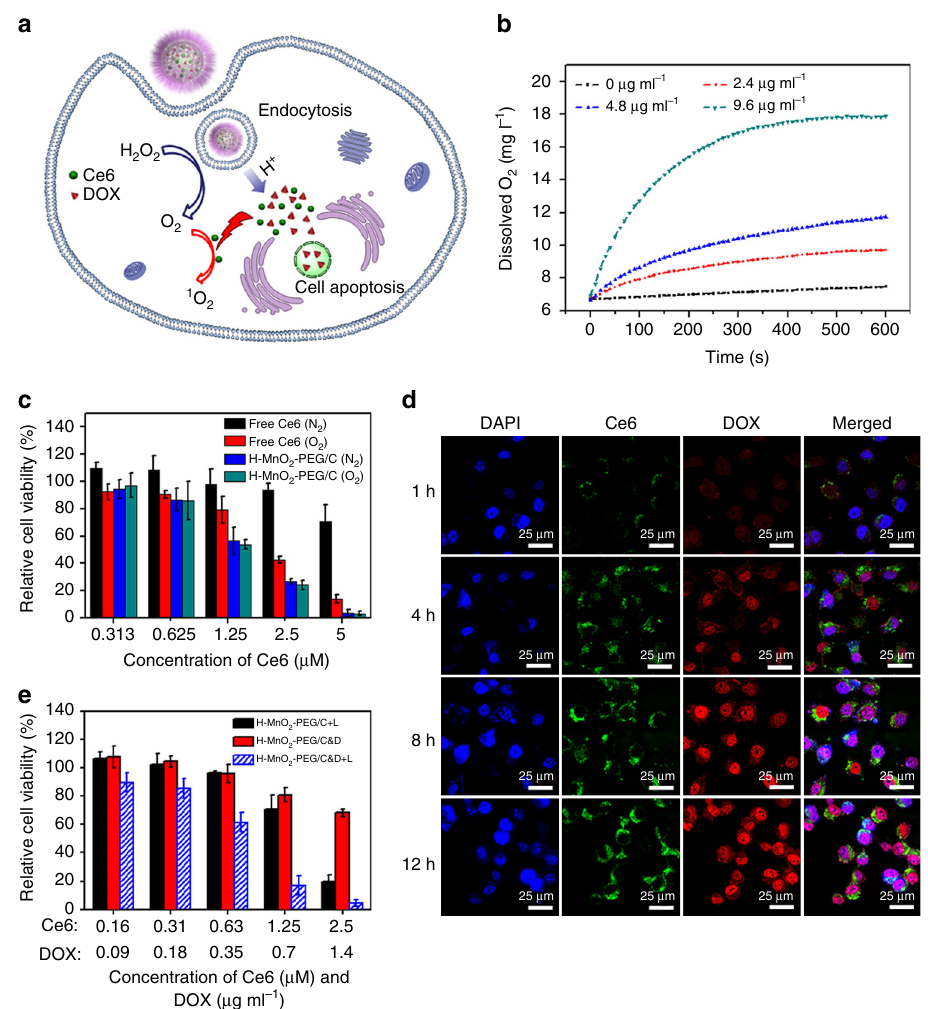
Fig. 3 In vitro experiments with H-MnO 2 -PEG/C&D. a A scheme illustration of H-MnO 2 -PEG/C&D for pH-responsive drug delivery and oxygen-elevated PDT. b The O 2 concentration changes in H 2 O 2 solutions (100 μ M) after various concentrations of H-MnO 2 -PEG/C&D were added. c In vitro PDT treatment of 4T1 cells by free Ce6 or H-MnO 2 -PEG/C under 660-nm light irradiation (5 mW cm − 2 for 30 min) in N 2 or O 2 atmospheres. d Confocal images of 4T1 cells treated with H-MnO 2 -PEG/C&D at different times points. Blue, green, and red represent DAPI, Ce6, and DOX fl uorescence, respectively. e Relative viabilities of 4T1 cells after incubation with H-MnO 2 -PEG/C with light irradiation, or H-MnO 2 -PEG/C&D with or without 660-nm light irradiation (5 mWcm − 2 , 30 min). Date are presented as means ± s.d. ( n =